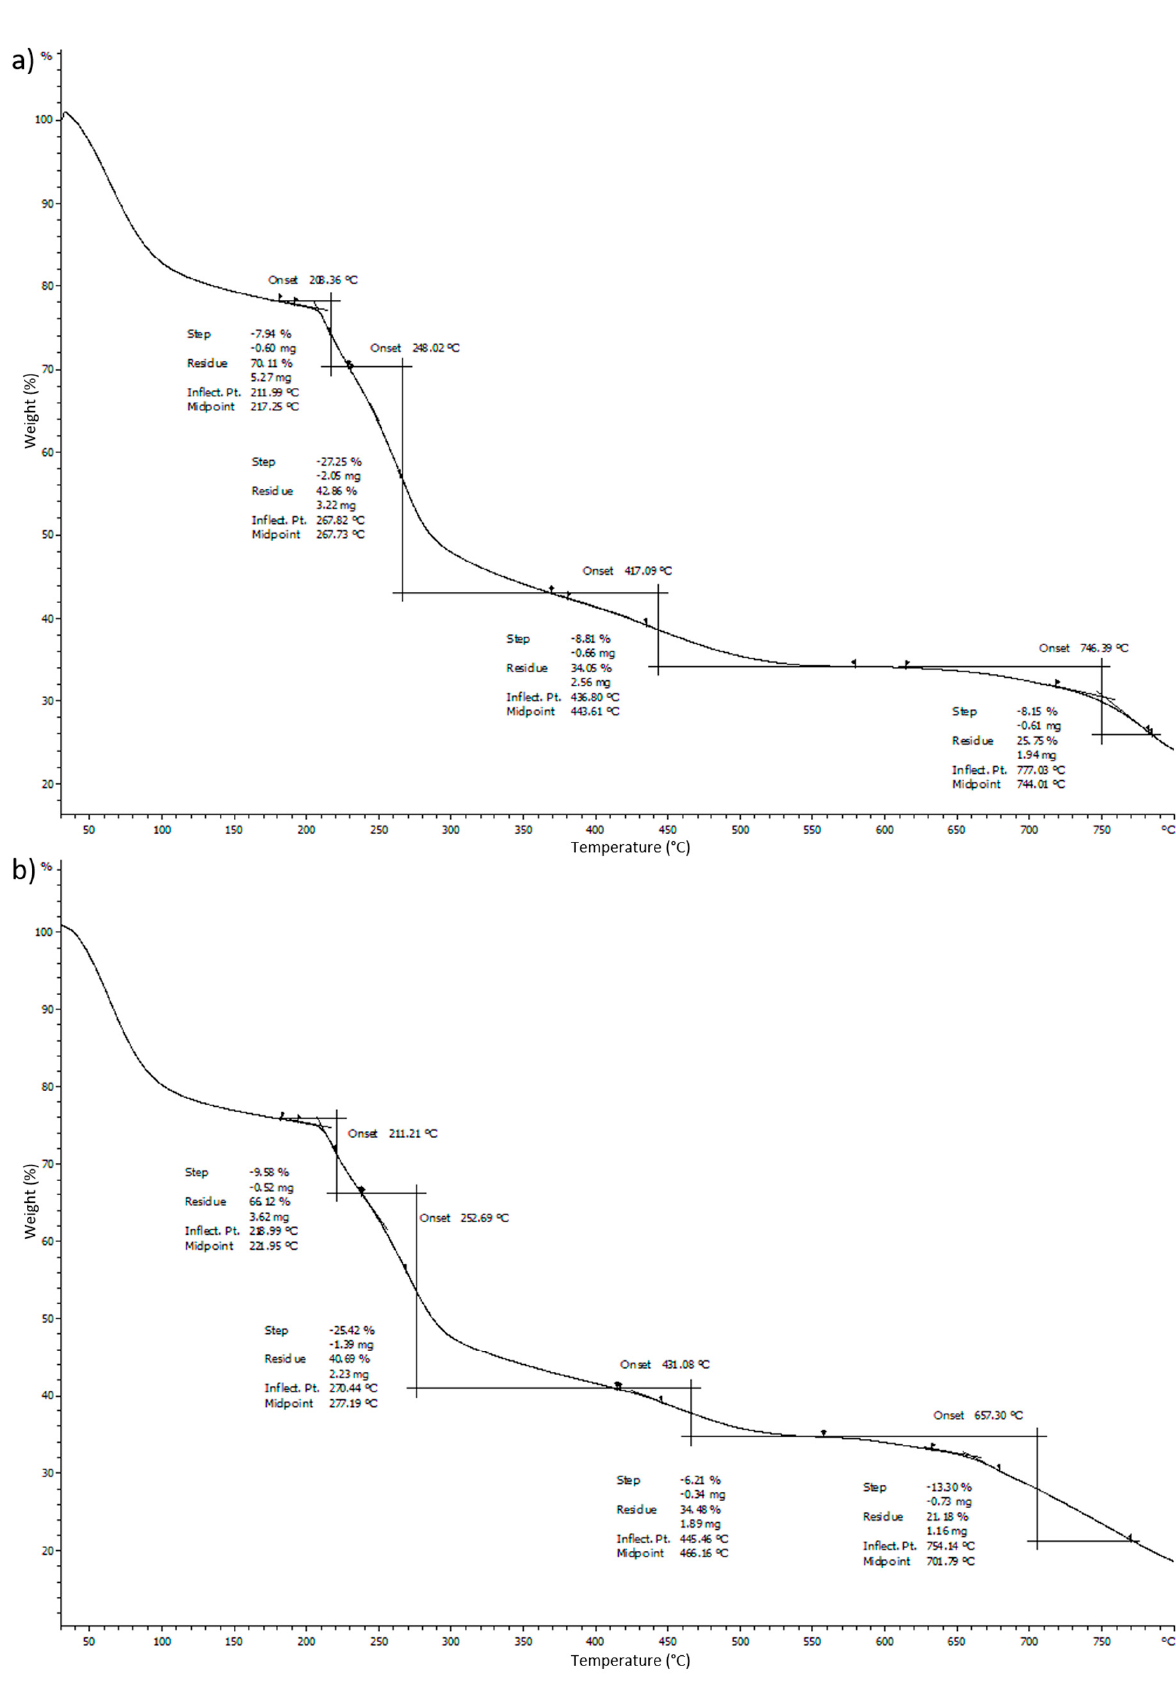
Figure 9. Thermogravimetric analysis (TGA) graph of ( a ) sodium alginate film) and ( b ) 0.5 g microbial composite film.